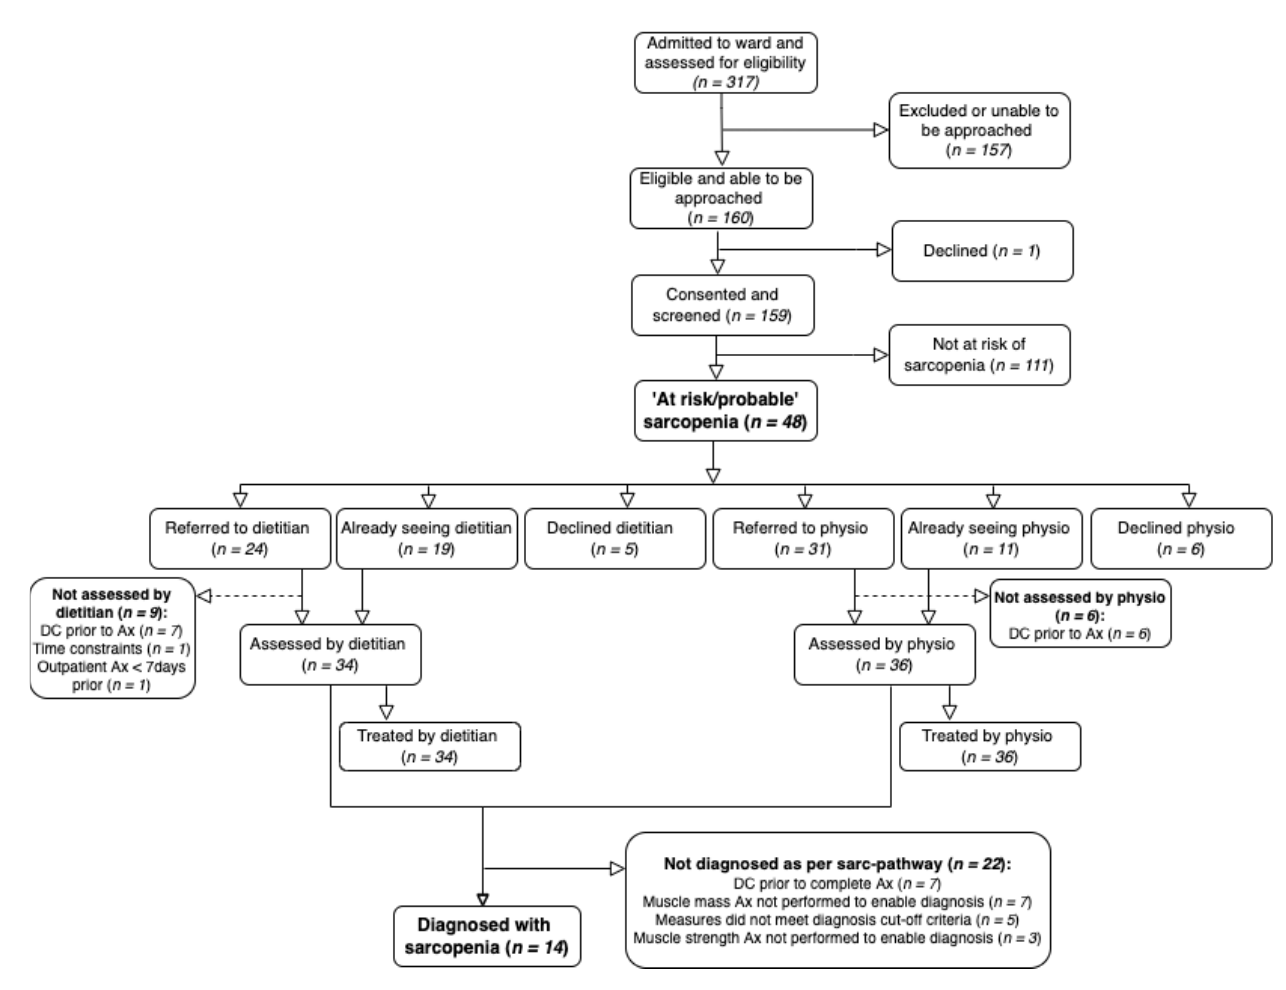
Figure 1. Participant flow diagram. Footnote: Abbreviations: physio = physiotherapist; DC = dis- Participant flow diagram. charged; Ax = assessment.